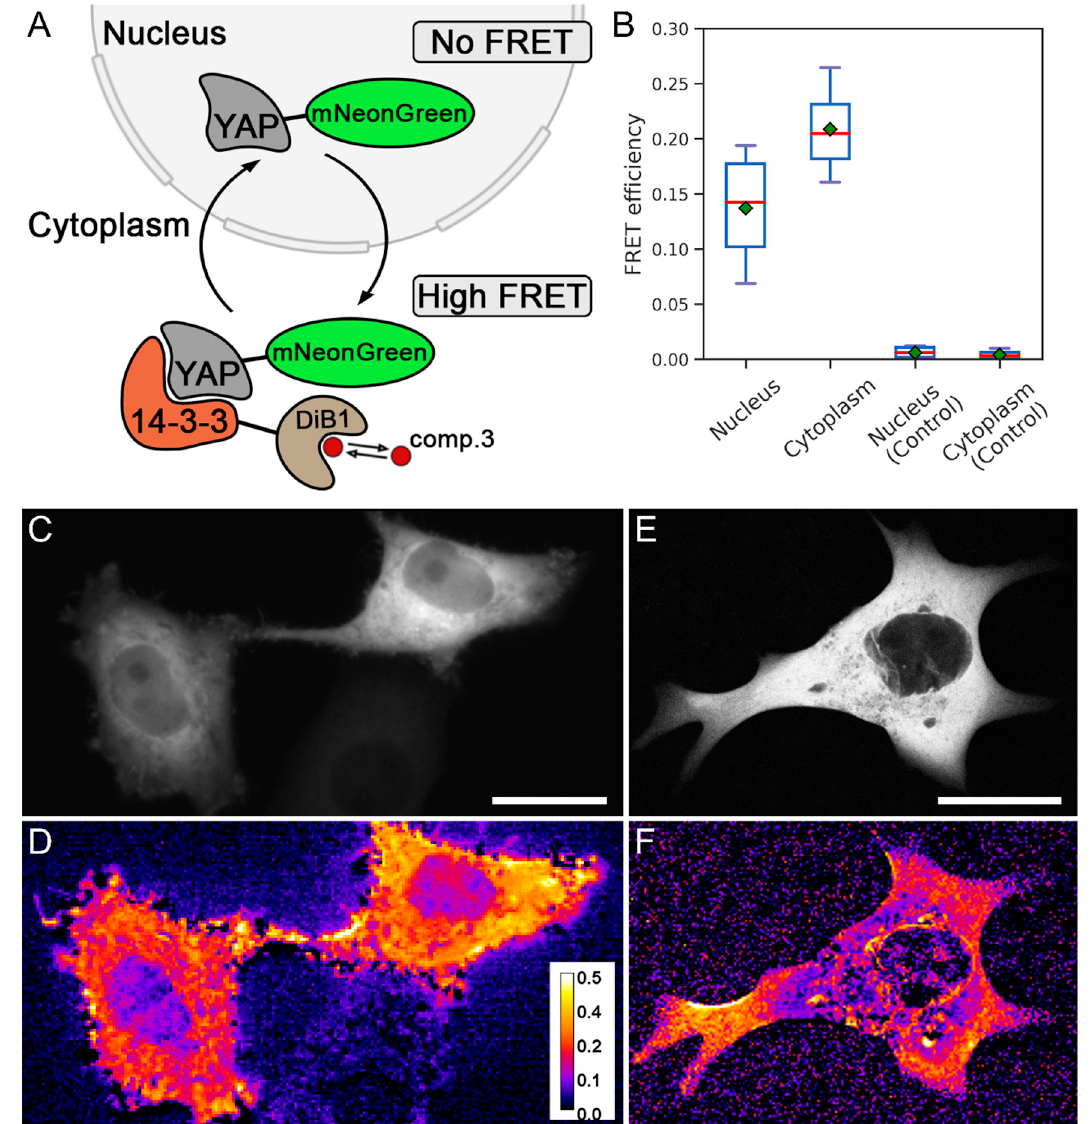
Figure 5. Detection of the interaction of YAP1 and 14-3-3 proteins. ( A ) Scheme of labeled proteins’ localization and their interaction. ( B ) FRET efficiency in different cell compartments (nucleus and cytoplasm) in experimental live HeLa Kyoto cells transiently cotransfected with two constructs, YAP1-mNeonGreen and 14-3-3-DiB1, and in live HeLa Kyoto cells transiently transfected with construct YAP-mNeonGreen. Red lines represent median values, green rectangles represent mean values (technical replicates = 11). ( C ) Widefield image of live HeLa Kyoto cells transiently cotransfected with YAP1-mNeonGreen and 14-3-3-DiB1 constructs. ( D ) Visualization of energy transfer in live HeLa Kyoto cells from panel ( C ); pseudocolor indicates FRET efficiency after the addition of 3 μ M compound 3 . ( E ) Confocal image of live HeLa Kyoto cells transiently cotransfected with YAP1-mNeonGreen and 14-3-3-DiB1 constructs. ( F ) Visualization of energy transfer in live HeLa Kyoto cells from panel ( E ); pseudocolor indicates FRET efficiency after the addition of 3 μ M compound 3 (panels D and F share the same color scale of FRET efficiency); scale bars are 20 μ m.